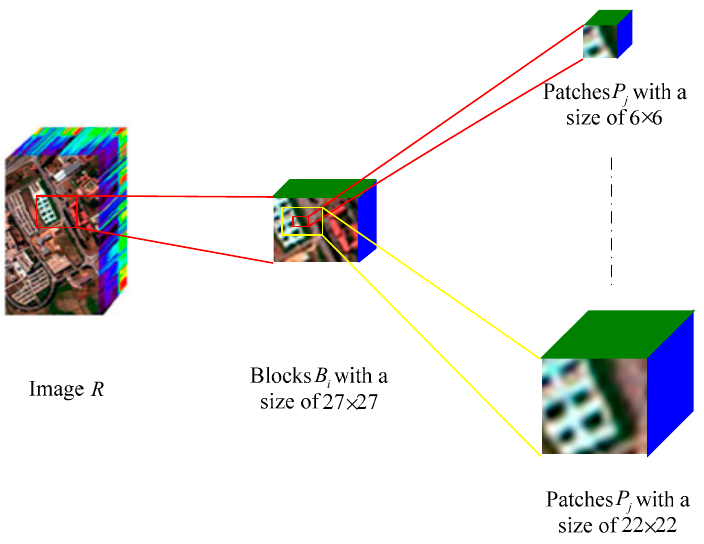
Figure 2. The block (sample) is extracted from image R and the different groups of samples with different sizes are extracted from block B i , B , respectively.